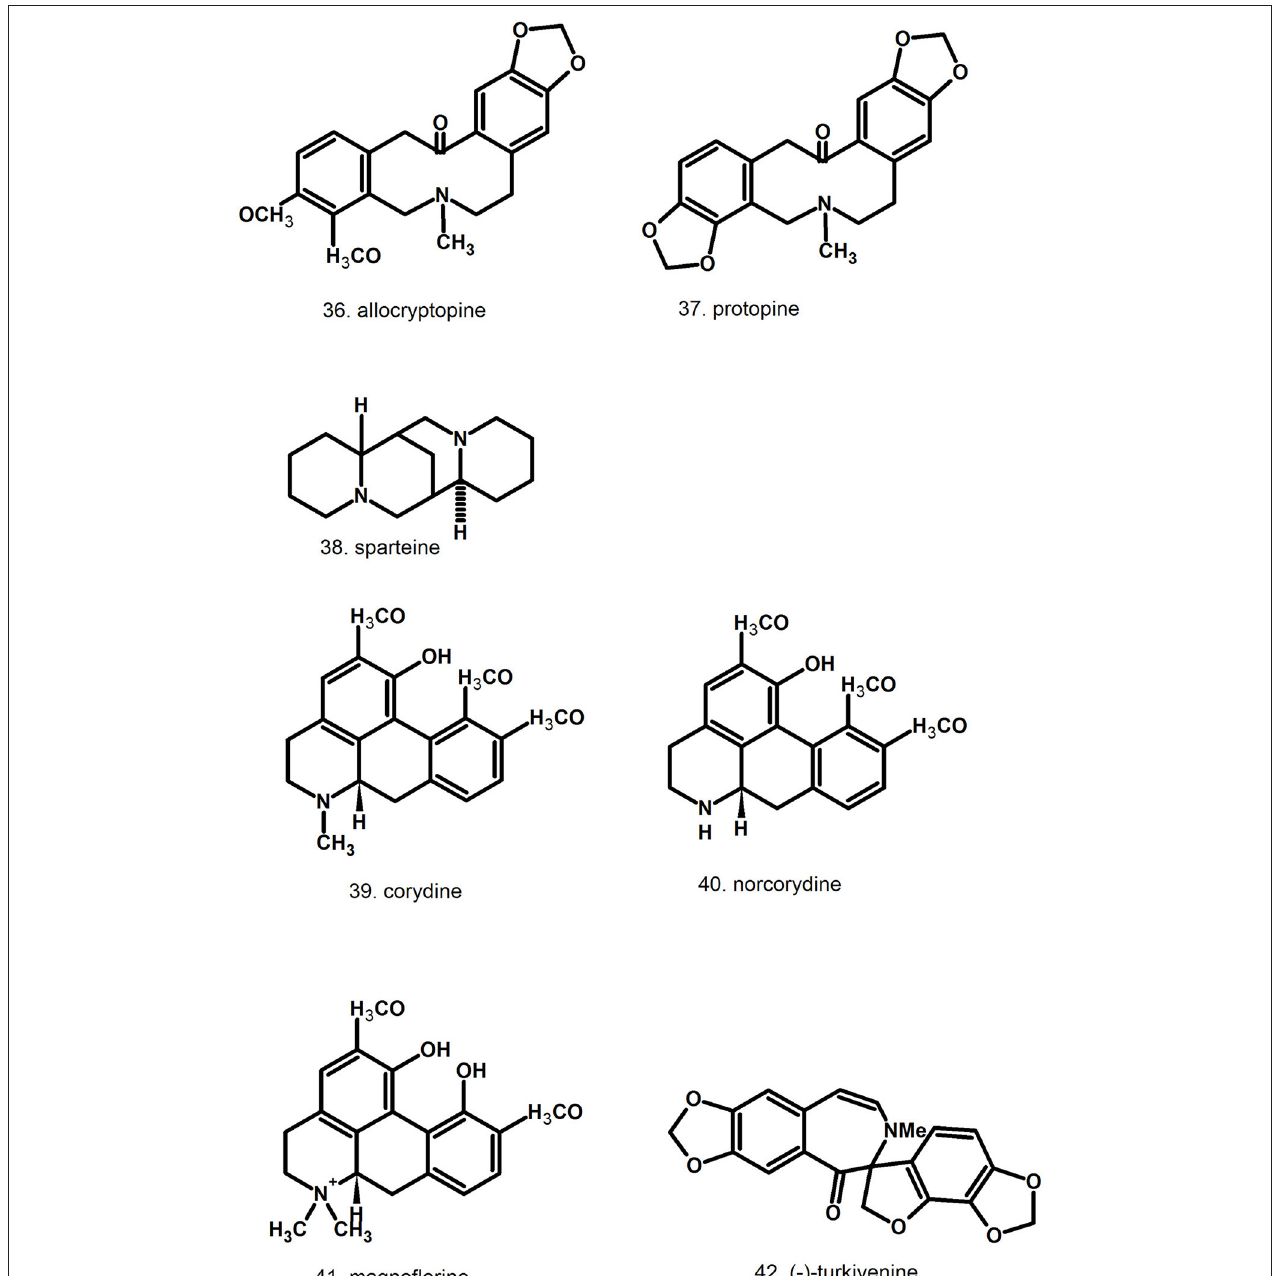
FIGURE 6 | Structures of aporphine, protopine alkaloids, and non-isoquinoline alkaloids.